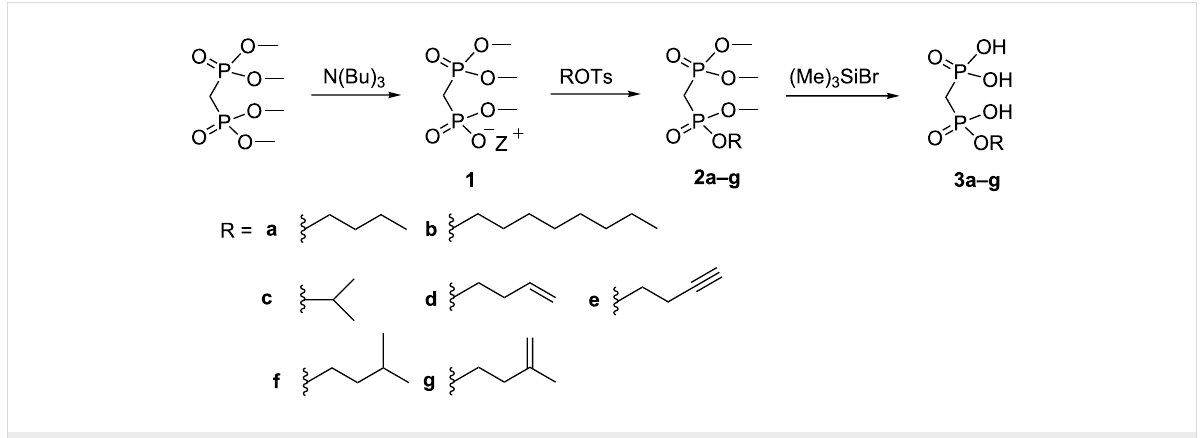
Scheme 2: Synthesis of medronic acid